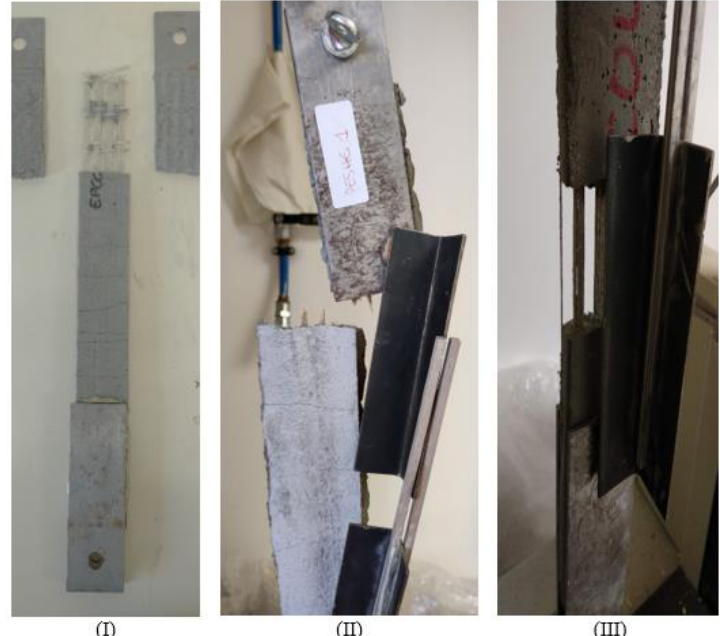
S23 to S30. Figure 8. Failure modes of FRCM. Figure 8. Failure modes of FRCM.